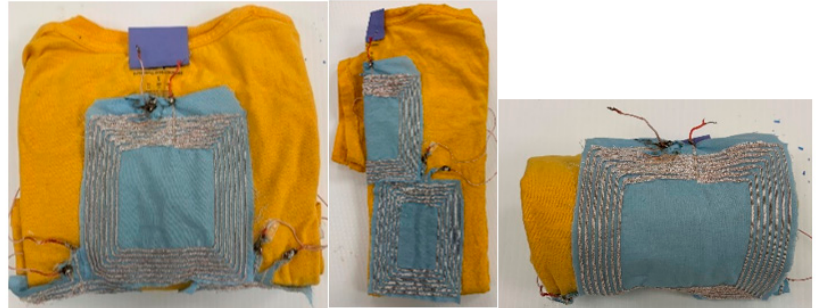
Figure 5. Embroidered RX coil array under different folding scenarios.